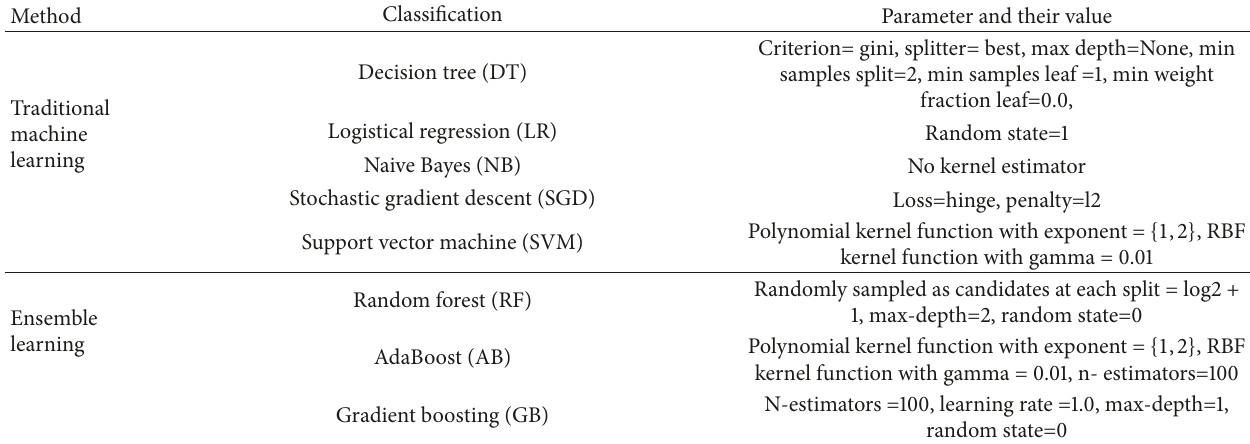
Table 7: List of machine learning methods.